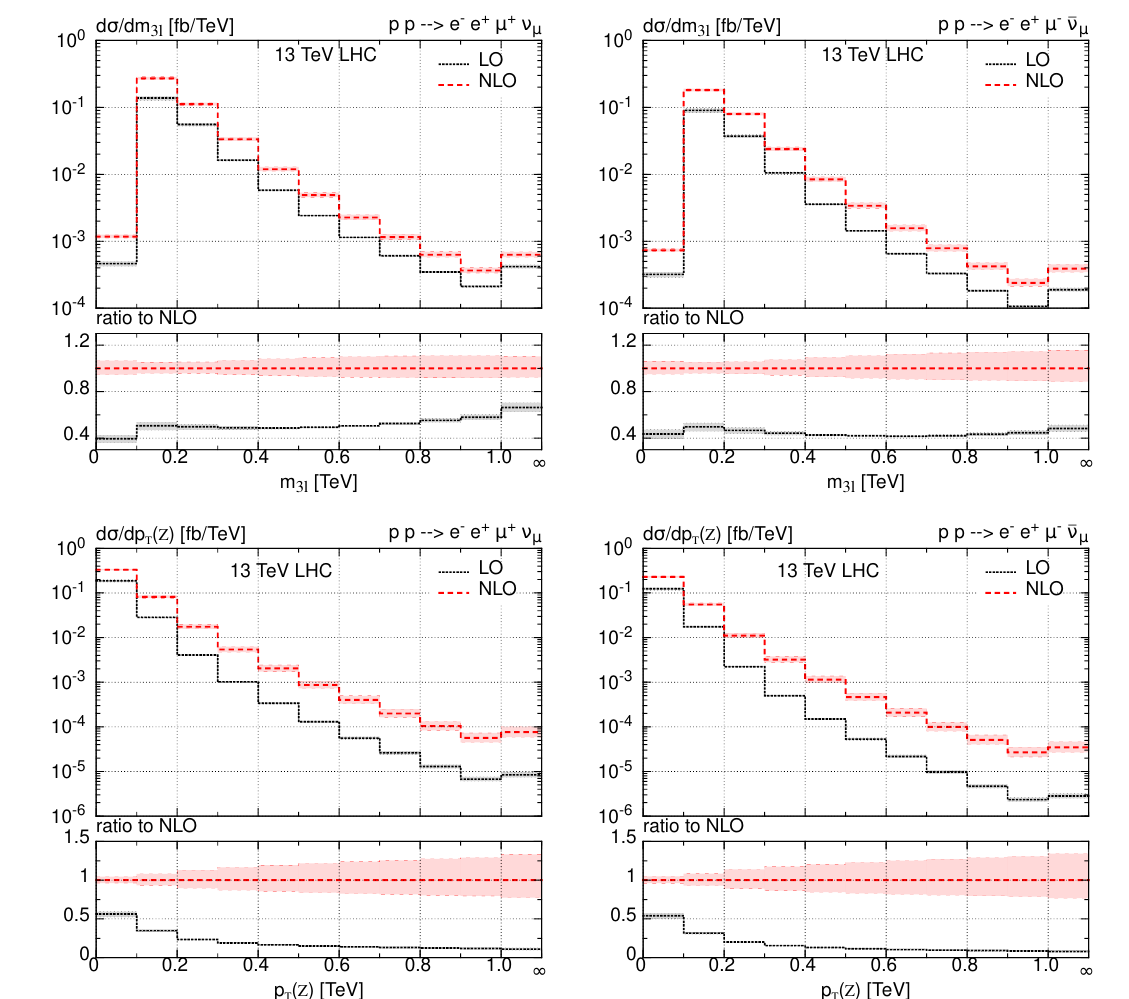
top-row ) and p bottom-row ) in the ZW + 3 l ( T ( Z ) (